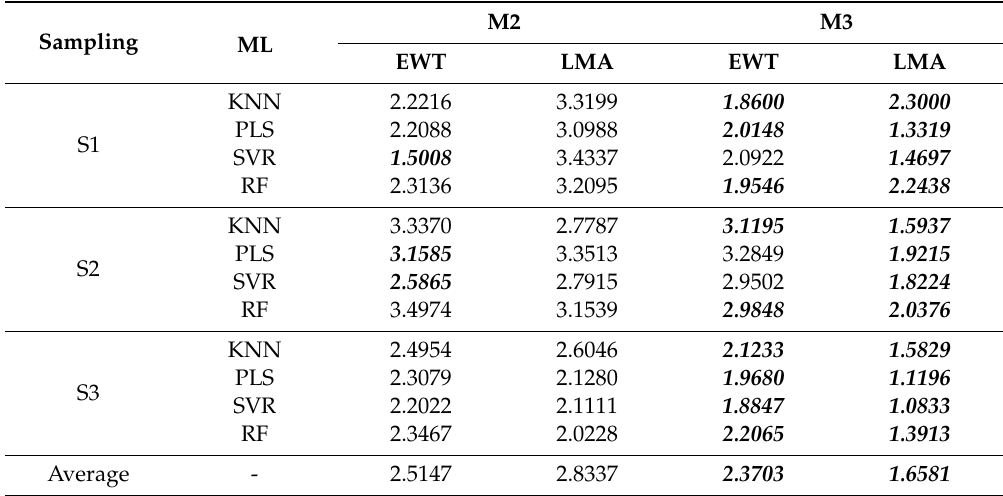
Table 7. RMSE of M2 and M3 for the estimation of leaf EWT and LMA. The italic bold numbers represent better prediction